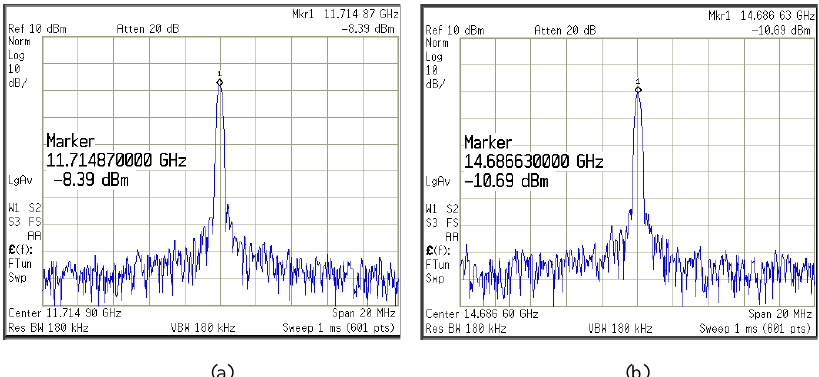
@ 3 MHz at the carrier frequency of 13 GHz.